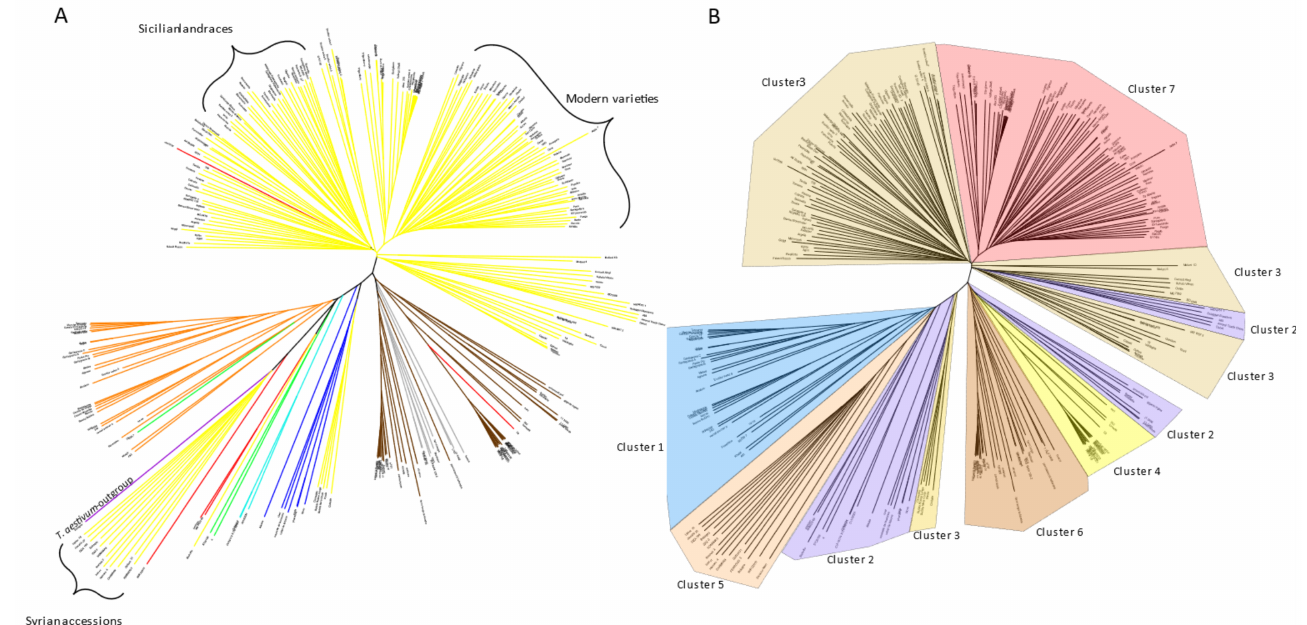
Figure 1. ( A ) Bayesian tree of 265 tetraploid wheat genotypes based on single-nucleotide polymorphism (SNP) genetic markers and colored according to subspecies classification. Branch colors: yellow for T. turgidum ssp. durum , orange for T. turgidum ssp. dicoccon , brown for T. turgidum ssp. turanicum , grey for T. turgidum ssp. polonicum , blue for T. turgidum ssp. turgidum , pale blue for T. turgidum ssp. paleocolchicum , red for T. turgidum ssp. carthlicum , green for T.turgidum dicoccoides, and violet for the T. aestivum outgroup accession. ( B ) Phylogenetic tree of 265 tetraploid wheat genotypes based on SNP genetic markers and colored according to discriminant analysis of principal components (DAPC)